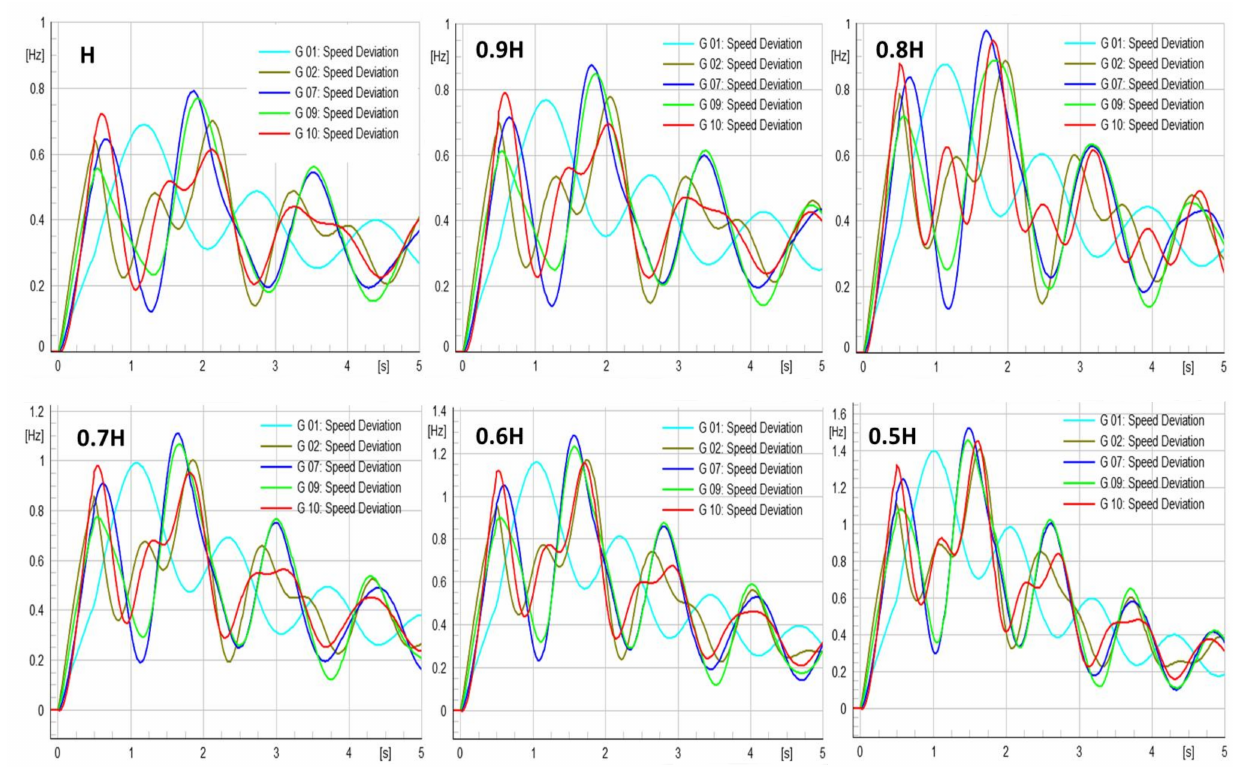
Figure 6. Speed deviation in the generators at different inertia